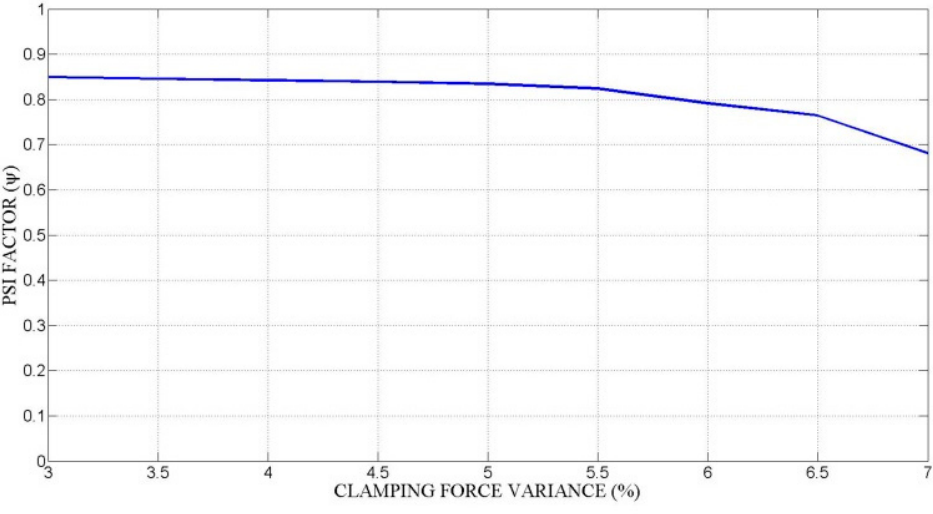
Figure 19. Variance of clamping force.